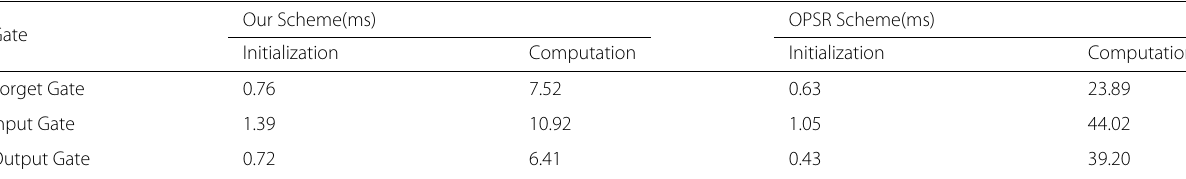
Table 5 Forward propagation runtime of each LSTM gate for each training sample Our Gate